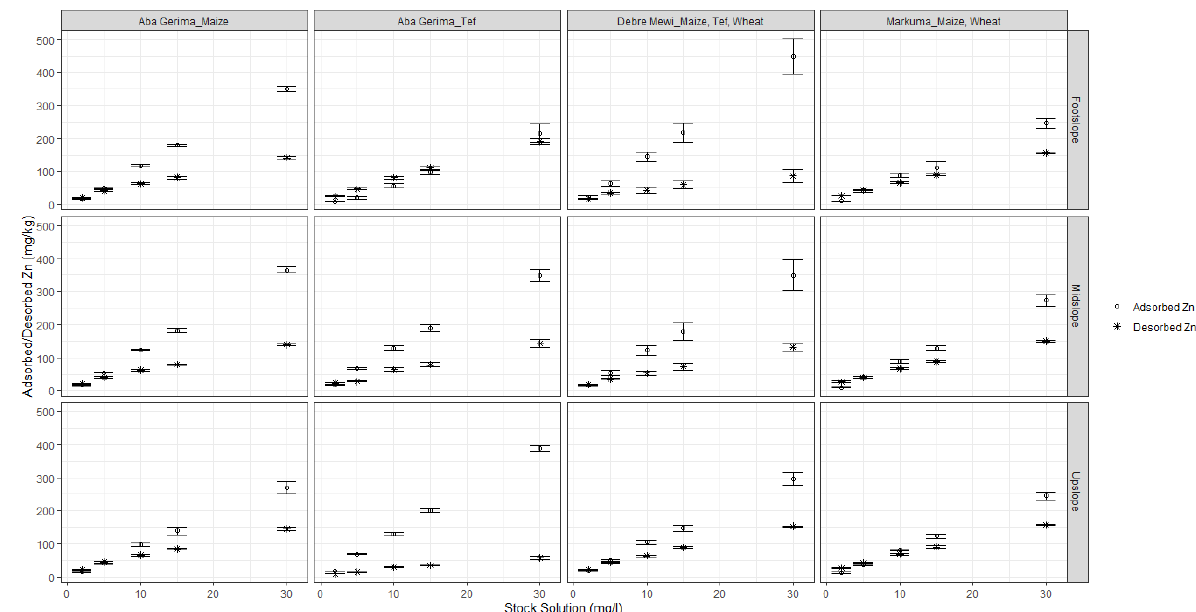
Figure 2. Stock solution concentration on adsorbed and desorbed Zn along the landscape positions. Generally, the percentage of adsorbed Zn increased with increasing initial Zn con- centrations at all sites (Figure 3). However, the adsorption rate reached a maximum with stock solutions of 5 mg Zn L − 1 at for Aba Gerima fields planted with tef while it needed 10 mg Zn L − 1 for this at Aba Gerima fields planted with maize and at Debre Mewi, except for the footslope at all sites which did not reach a plateau. However in Markuma, the per- centage and rate of Zn adsorption kept increasing with increasing initial Zn concentrations in all landscape positions (Figure 3) because most of the soil parameters were similar across the topo sequence (Tables 1 and 2).